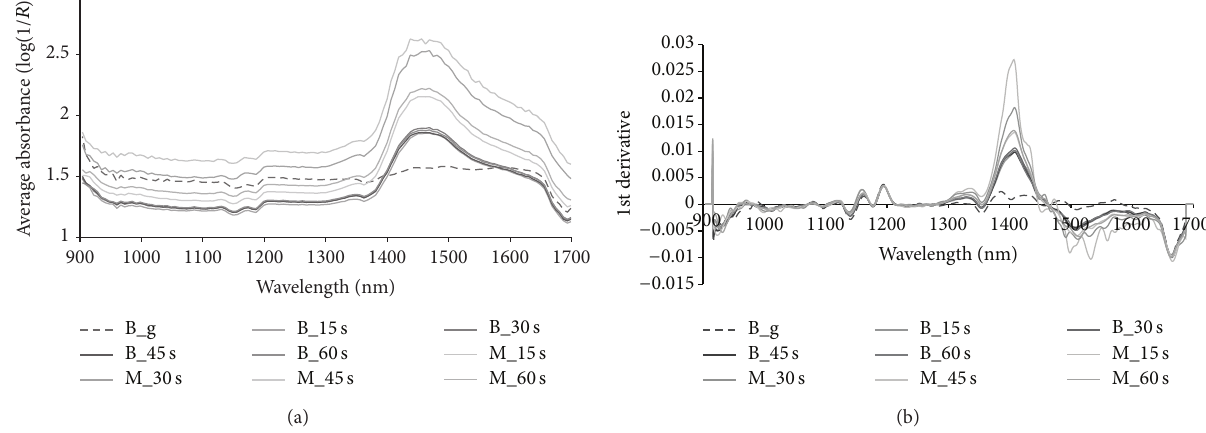
Figure 1: (a) NIR absorbance spectra and (b) first derivative of NIR spectra for barley grain (B g), barley milk (M), and spent grain (B) after 15, 30, 45, and 60 seconds of blending.